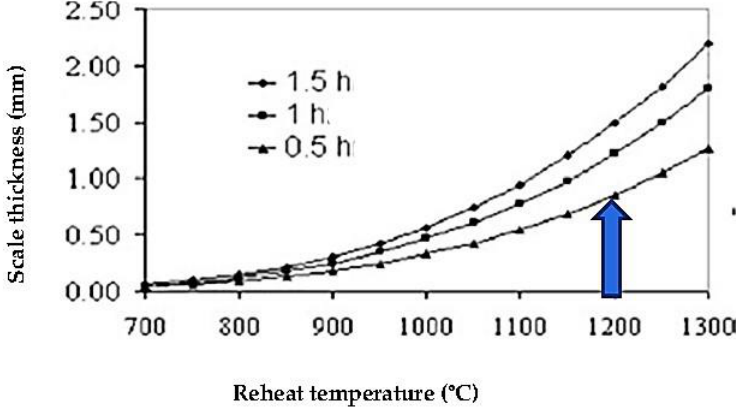
Figure 10. Scale thickness versus temperature (reproduced from [20], with permission from the authors, 2014).